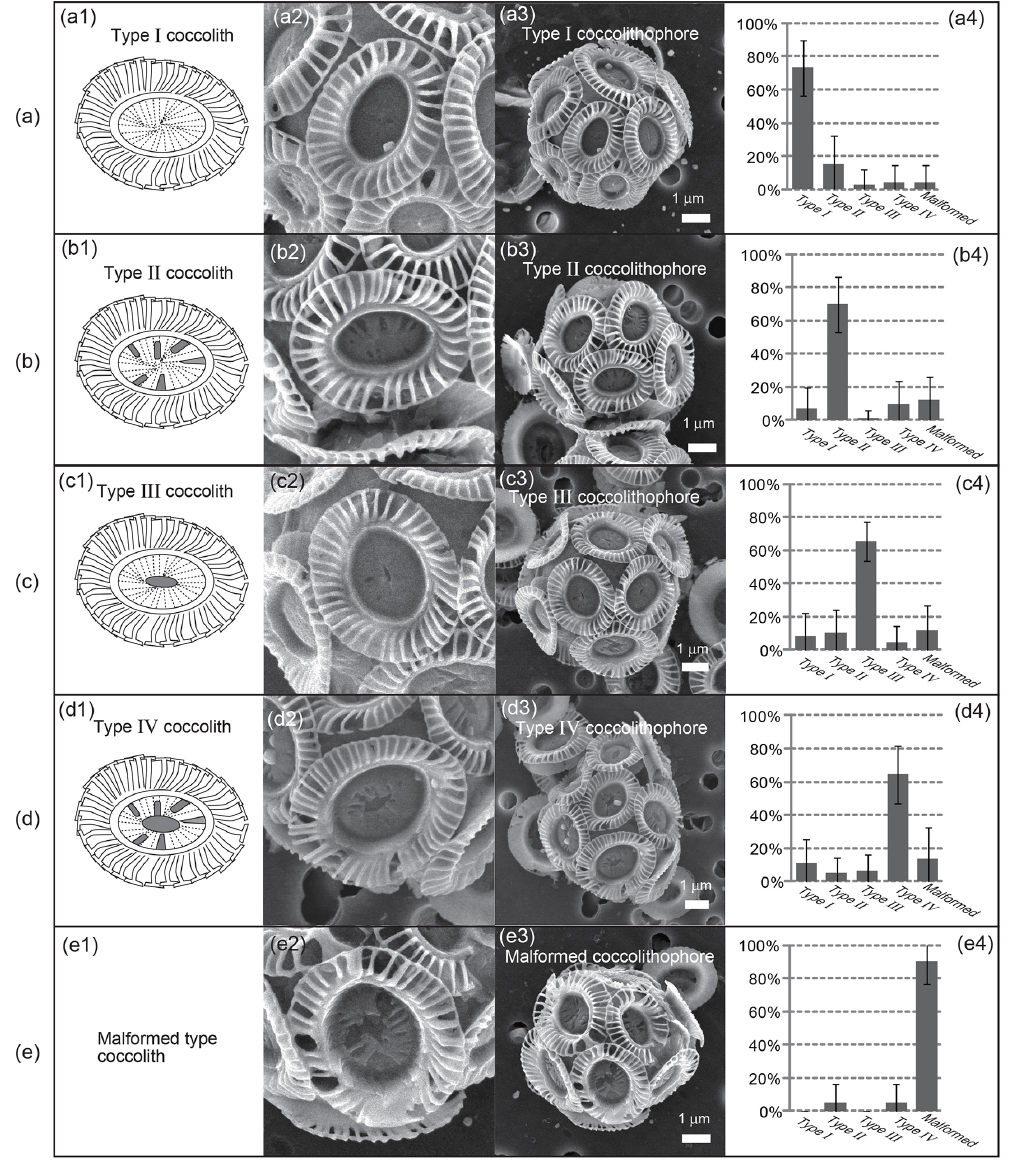
Figure 5. Four submorphotypes (Types I–IV) of MR70N coccoliths, coccolithophores, and malformed cells were categorized by morphology on the basis of SEM images. (a1) Schematic drawing of Type I, whose central area elements are completely calcified, similar to the SEM image shown in (a2) . (b1) Schematic of Type II, whose central area elements are partially calcified or with lath-like spaces similar to the SEM image shown in (b2) . (c1) Schematic drawing of Type III, whose central area is opened with a hole in the center with well-calcified marginal area, similar to the SEM image shown in (c2) . (e1) Schematic drawing of Type IV, whose central area is opened with a hole in the center and a less-calcified marginal area, similar to the SEM image shown in (e2) . A SEM image of the malformed type is shown in (e2) ; the distal shield elements are not well calcified and show an irregular morphology. In (a3) to (e3) are coccolithophore cells of each coccolith type; histograms (a4) to (e4) indicate the proportions of the various coccolith morphotypes (see